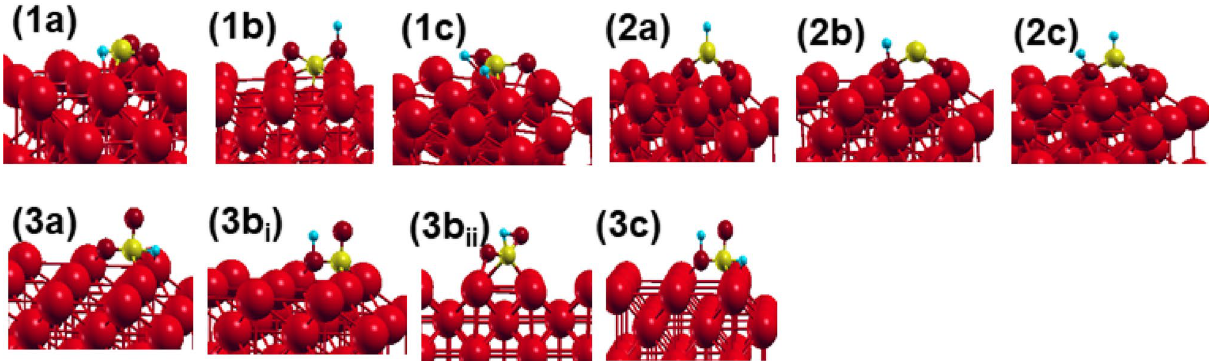
Fig. 3 Guess structures for the hydrogenation of CO